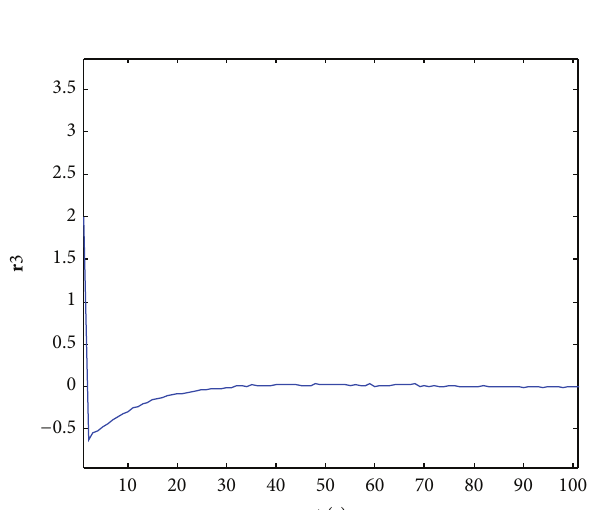
Figure 3: The missile trajectory character.